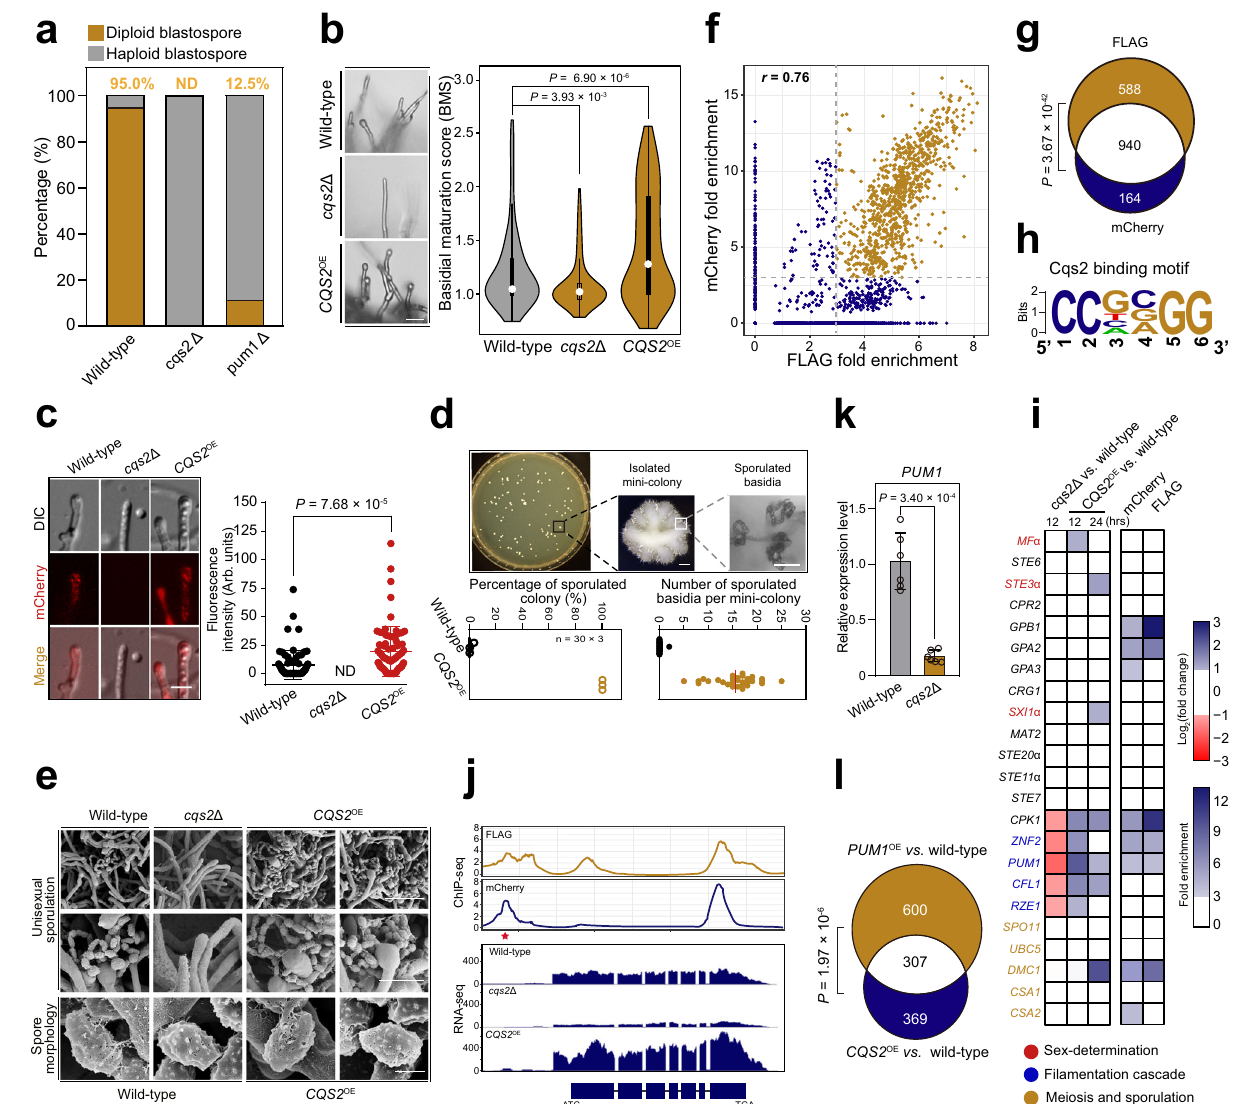
Fig. 5 | Cqs2 drives and coordinates multistage unisexual reproduction by coordinating the expression of multiple genes involved in various unisexual stages. a FACS-based ploidy assessment of blastospores dissected from unisexual hyphae of different strains. For each strain, 40 blastospores dissected from dif- ferent unisexual hyphae were tested for ploidy level. ND not detected. b Basidial formationandBMSdistributionofwild-type, cqs2 Δ ,and CQS2 OE (P H3 - CQS2 ).Hyphae with or without basidia were photographed at 5 days post unisexual stimulation and were randomly chosen for the BMS calculation ( n =150 for each strain). Box- plots show the median and the upper and lower central quartiles. The expected range of the data is indicated by whiskers. Scale bar: 10 μ m. Two-tailed Student ’ s t test. c The fl uorescence-labeled strains were photographed at 3 days post- inoculation on V8 agar to stimulate unisexual reproduction. For each strain, 70 basidiawereexamined forthe expressionofDmc1-mCherry. Data are presentedas the mean±SD. ND not detected. Two-tailed Student ’ s t test; scale bar: 10 μ m.